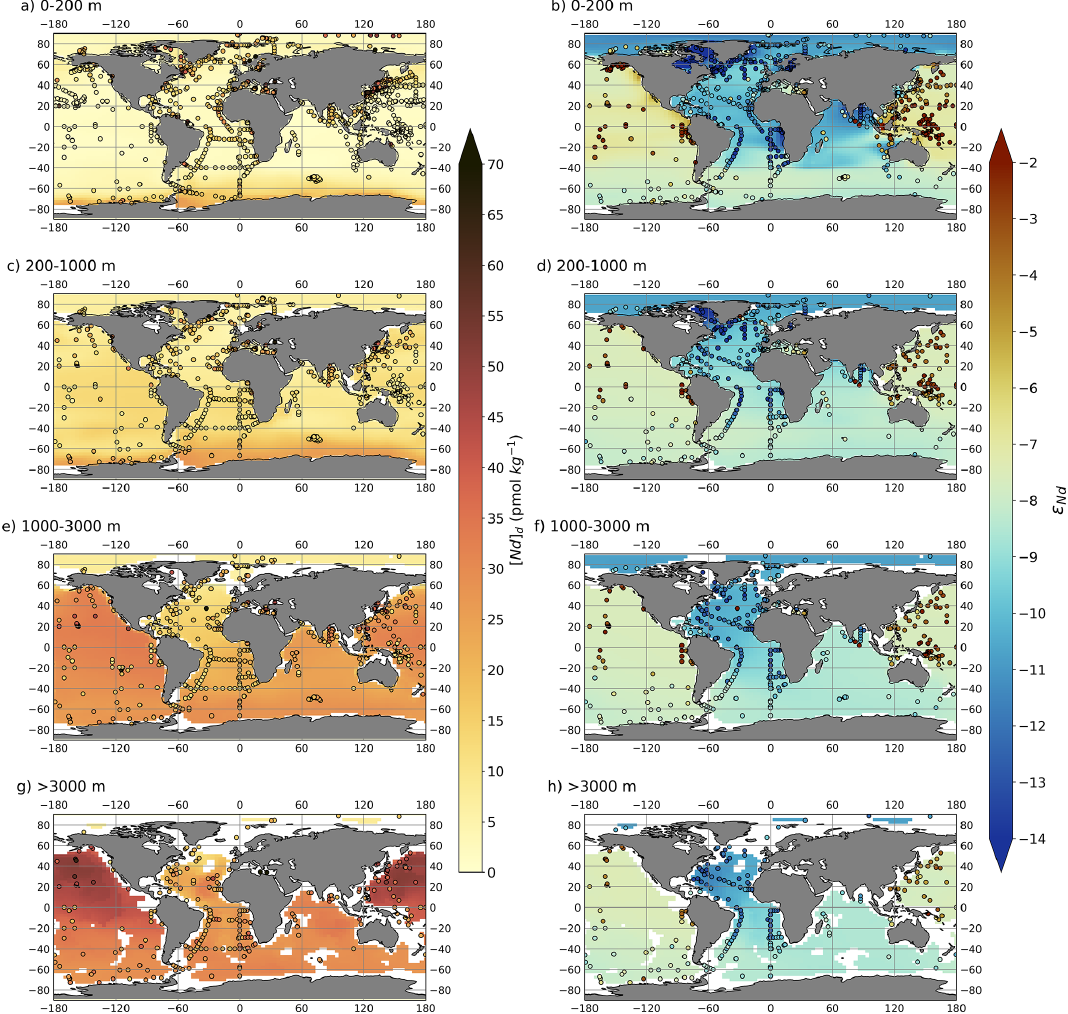
Figure 10. Maps of [Nd] d (left column) and ε Nd (right column) in simulation EXPT_RS4 split into four different depth bins: (a–b) shallow (0–200m), (c–d) intermediate (200–1000m), (e–f) deep (1000–3000m), and (g–h) deep abyssal ocean ( > 3000m). Water column measure- ments from within each depth bin (Osborne et al., 2017, 2015; GEOTRACES Intermediate Data Product Group, 2021) are superimposed as filled circles using the same colour